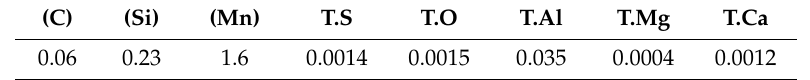
Table 1. Average chemical composition of the Al-killed Ca-treated steel in the current study (wt%).